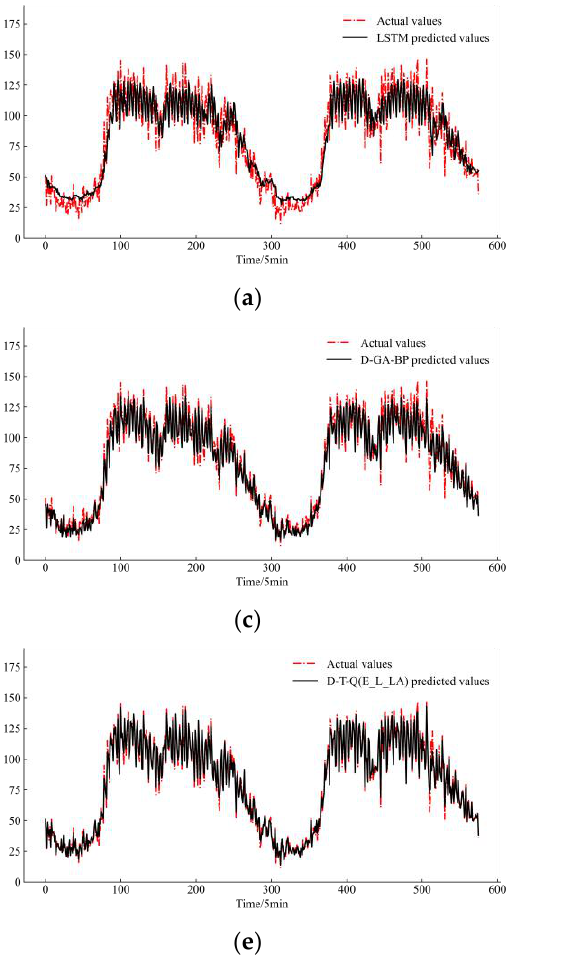
Figure 12. Prediction effect of each model. ( a ) LSTM; ( b ) CNN-GRU; ( c ) D-GA-BP; ( d ) D-LightGBM; ( e ) D-T-Q (E-L-LA); ( f ) prediction error.